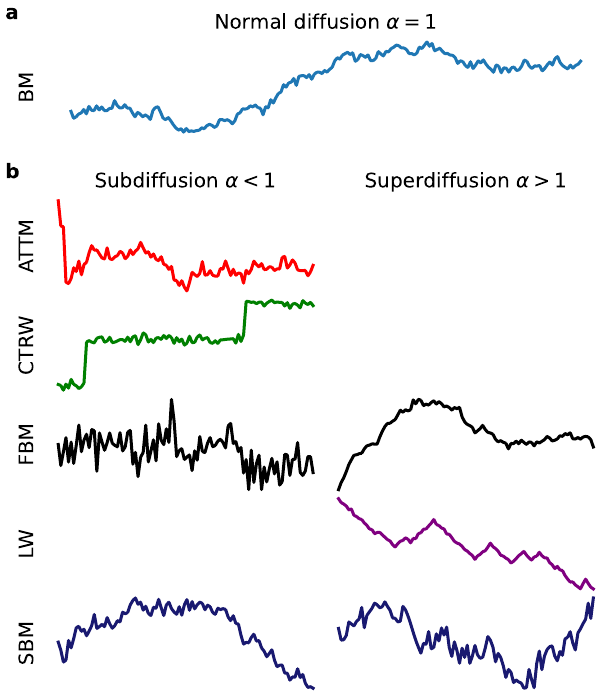
Fig. 1 | Illustrationofdifferent diffusion models. We show sample trajectories of normal ( a ) and anomalous ( b ) diffusion. All shown trajectories are corrupted by white Gaussian noise.